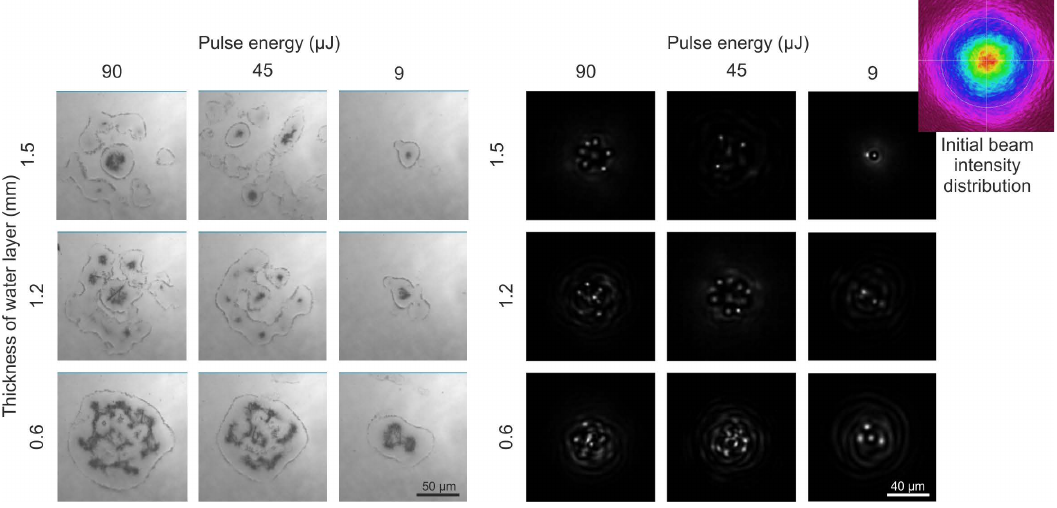
Figure 3. Ablation patterns acquired experimentally ( left ) and by modeling the modified Schrodinger equation ( right ) given different pulse energy settings and water thickness